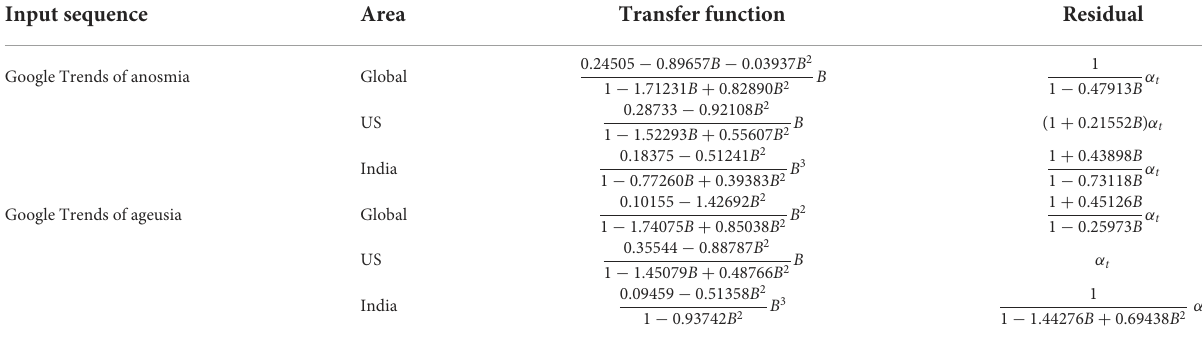
TABLE 3 Forecast values and 95% confidence interval for the following 4